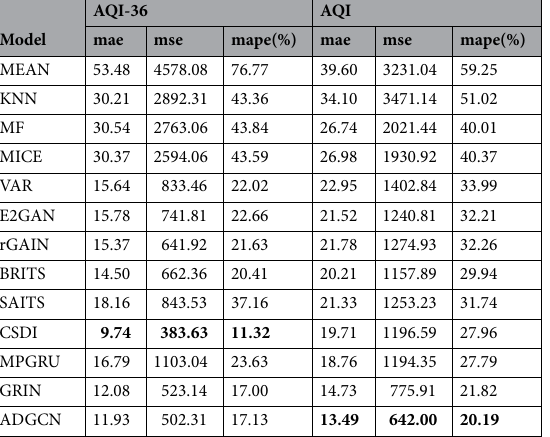
METR-LA Blocking